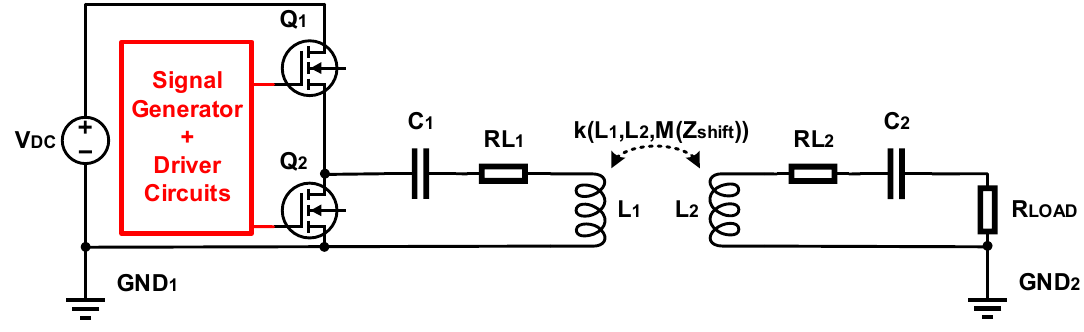
Figure 1. Basic electric scheme of wireless charging systems (WChS) with serial-serial resonant compensation end equivalent secondary DC load resistance.